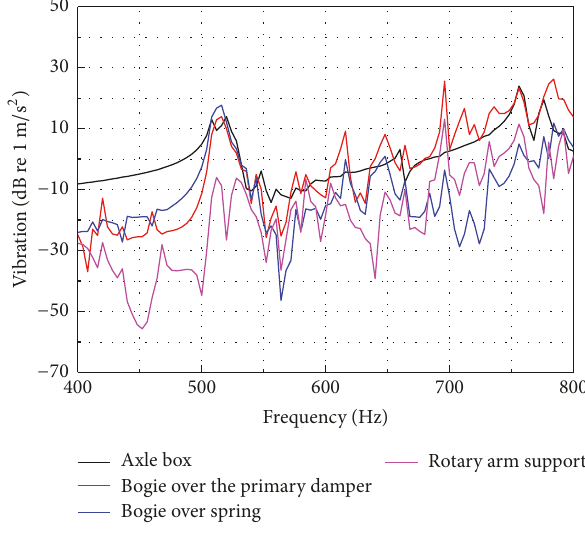
Figure 10: Vibration in one-third octave. Figure 11: Vibration in